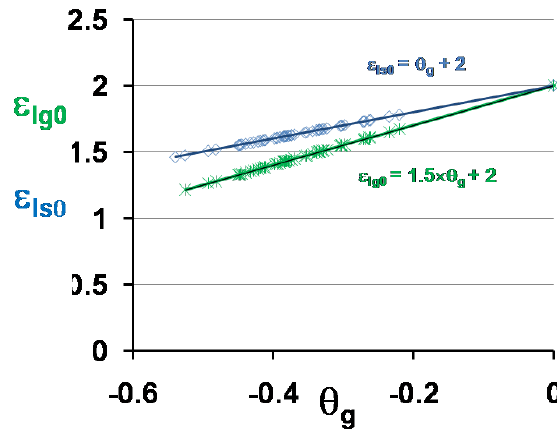
Figure 4. The calculated values of the free-volume disappearance temperature T fragile glass-forming melts are plotted versus the VFT temperatures T measurements in the vicinity of T